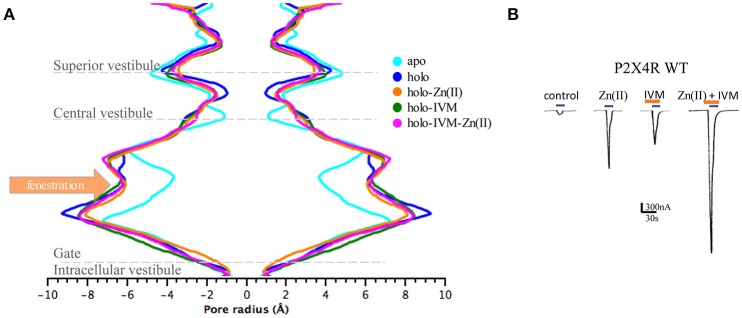
Allosteric modulators induced changes in the pore radius of the extracellular P2X4R vestibule in different states of the P2X4R. (A) Pore dimensions obtained during the last 10 ns MD simulations of the P2X4R in apo or holo state, holo with Zn(II) or with IVM, and the holo P2X4R with both IVM and Zn(II), along the vestibular portions of the P2X4R. (B) Representative tracings obtained in a single oocyte expressing the wt P2X4R following 1 μM ATP-evoked currents in the absence of modulators, and following incubation with either 10 μM Zn(II), 3 μM IVM, or the joint application of IVM plus Zn(II). In all cases 1 μM ATP-evoked currents were recorded (blue rectangles), while IVM applications are shown in brown rectangles.